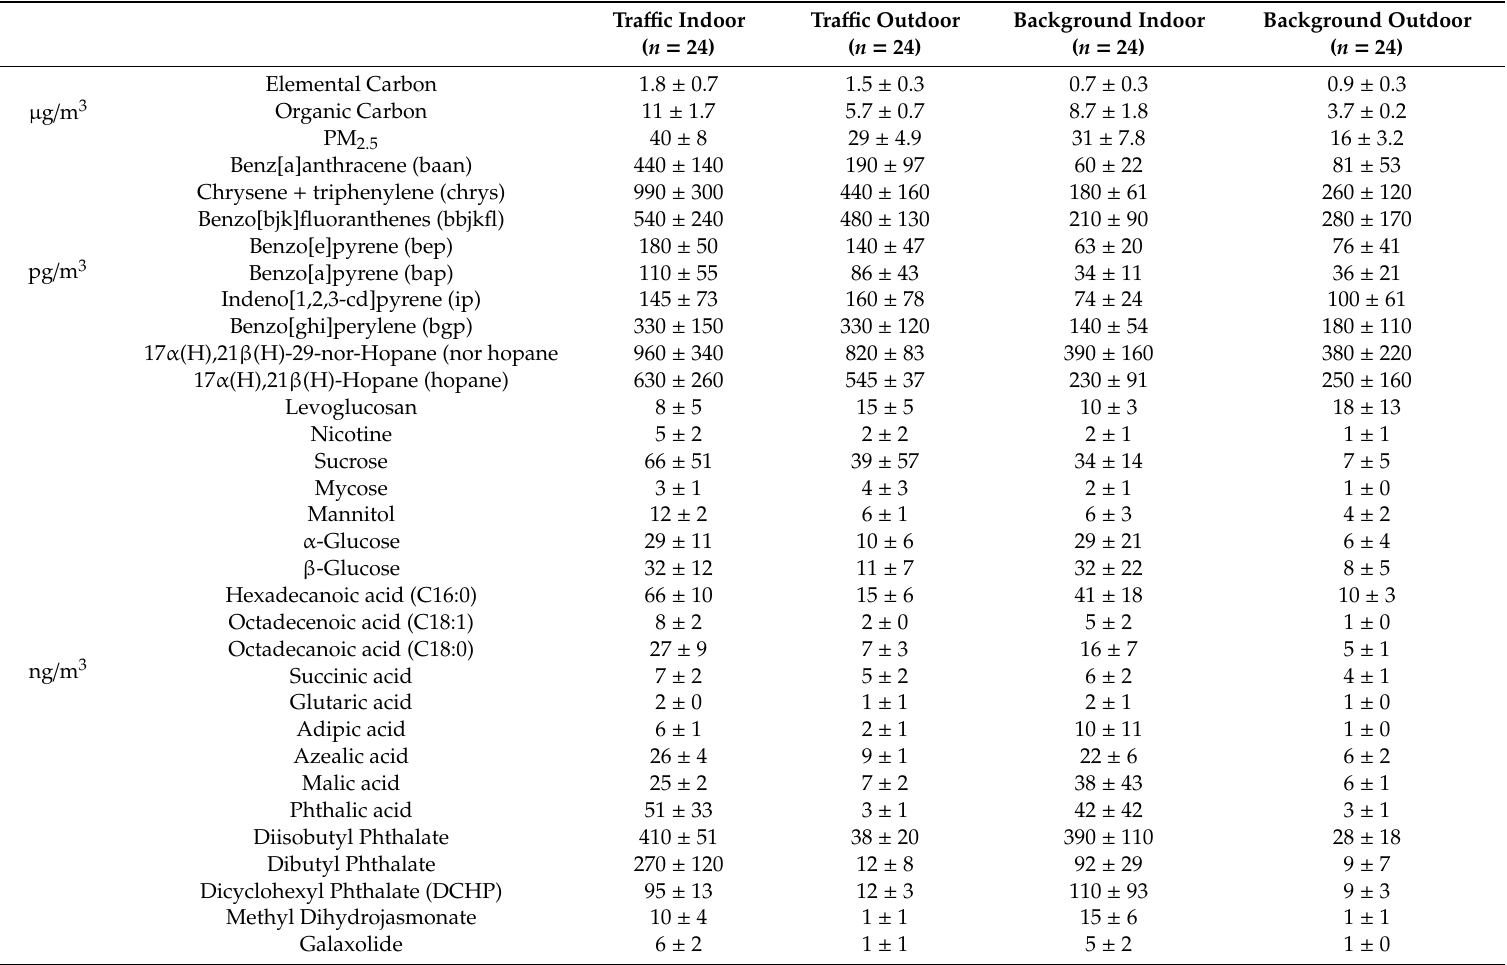
Table 1. Mean concentrations and standard deviations of organic tracer compounds in the indoor and outdoor aerosols of the schools located near tra ffi c and background